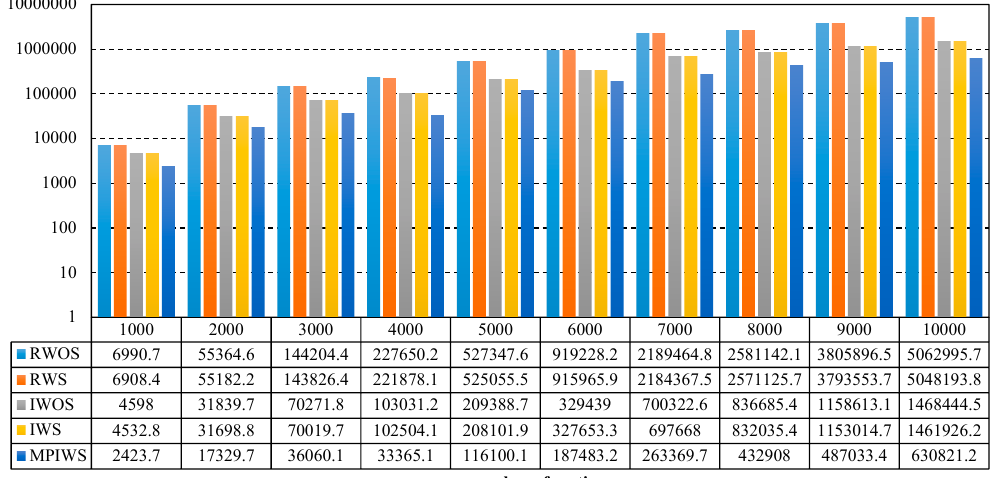
Figure 3. Impacts of number of vertices on execution time of each algorithm.